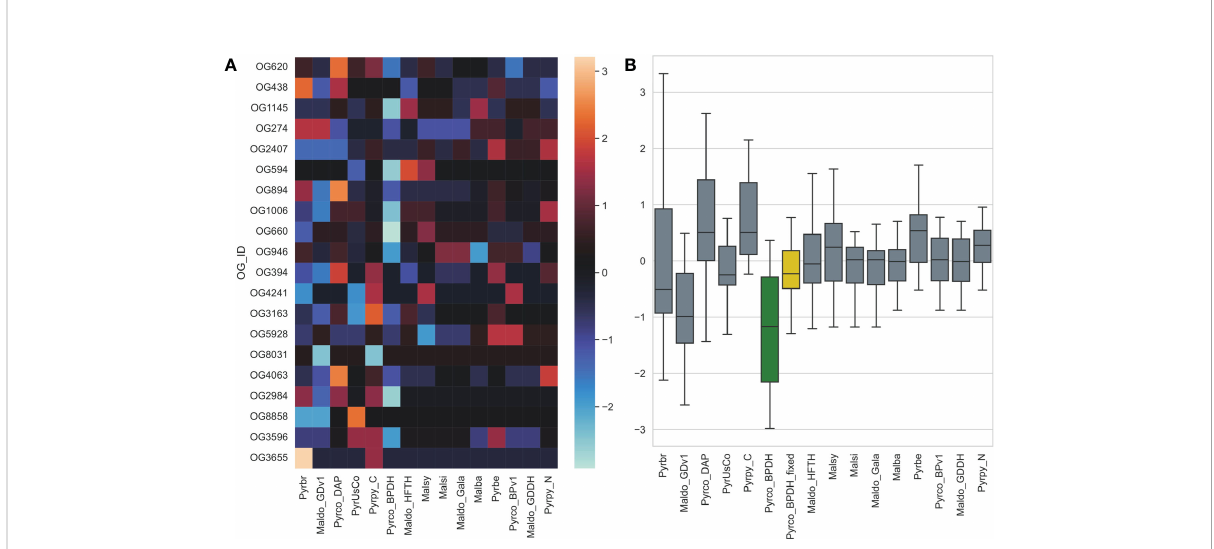
FIGURE 10 The gene count z-score of selected tree architecture gene families across Pyrus and Malus genomes. Pyrco_BPDH orthogroups have lower z- scores than most others, which is shown with a cooler color in the heatmap (A) and lower average z-score (green box in B ), indicating fewer than expected gene counts. These missing genes were discovered after the targeted re-annotation process, which brought the average gene count z-score closer to 0 (yellow box in B ) and comparable to other high-quality genomes. Genome abbreviations can be found in Supplemental Table